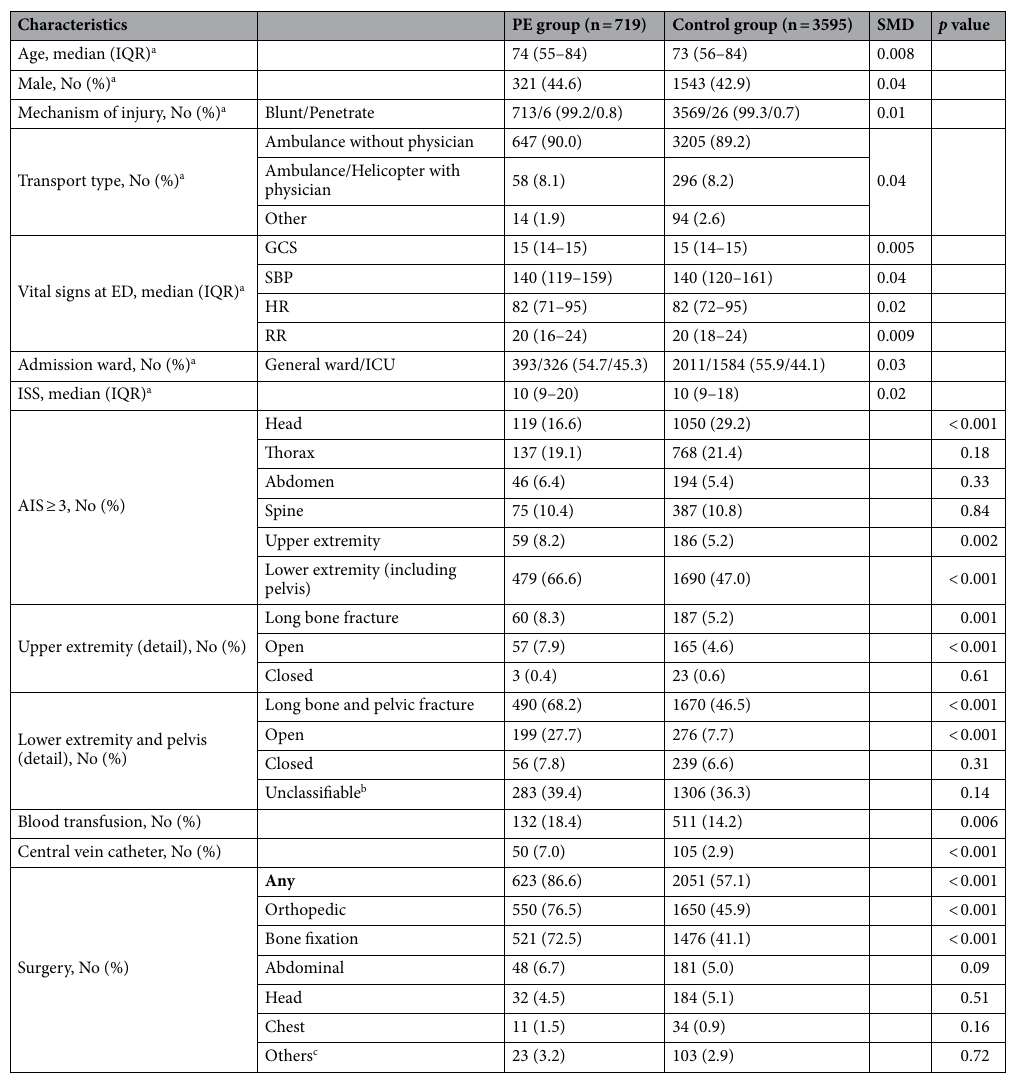
Table 1. Baseline characteristics of patients with and without pulmonary embolism. Missing data: None. PE pulmonary embolism, SMD standardized mean difference, IQR interquartile range, ED emergency department, matching. b AIS90 Update 98 included lower extremity and pelvic fracture codes which represent both open and closed fracture. c Other surgeries include facial, neck, and skin surgeries.